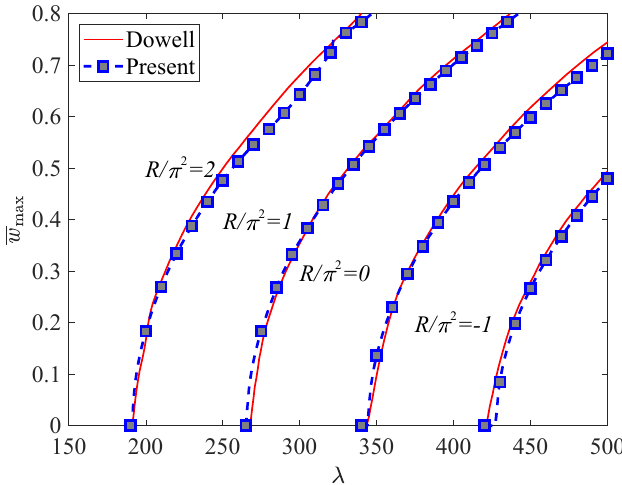
Figure 4. Limit cycle amplitude. vs. dynamic pressure.